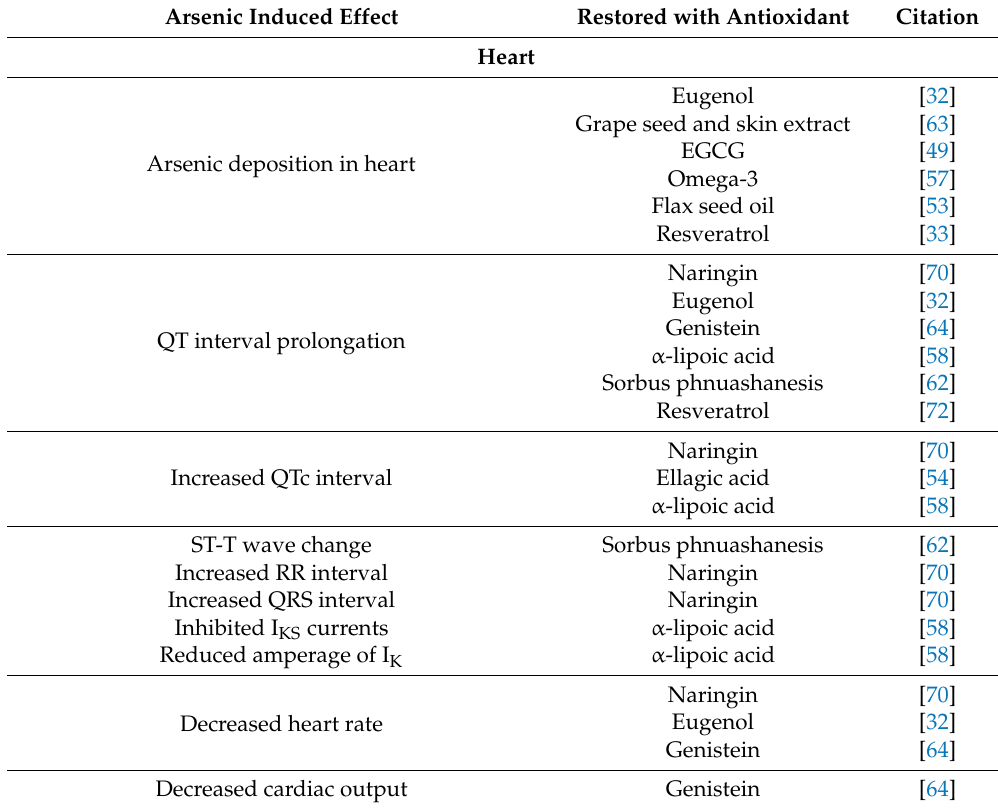
Table 3. Arsenic induced effects and antioxidant